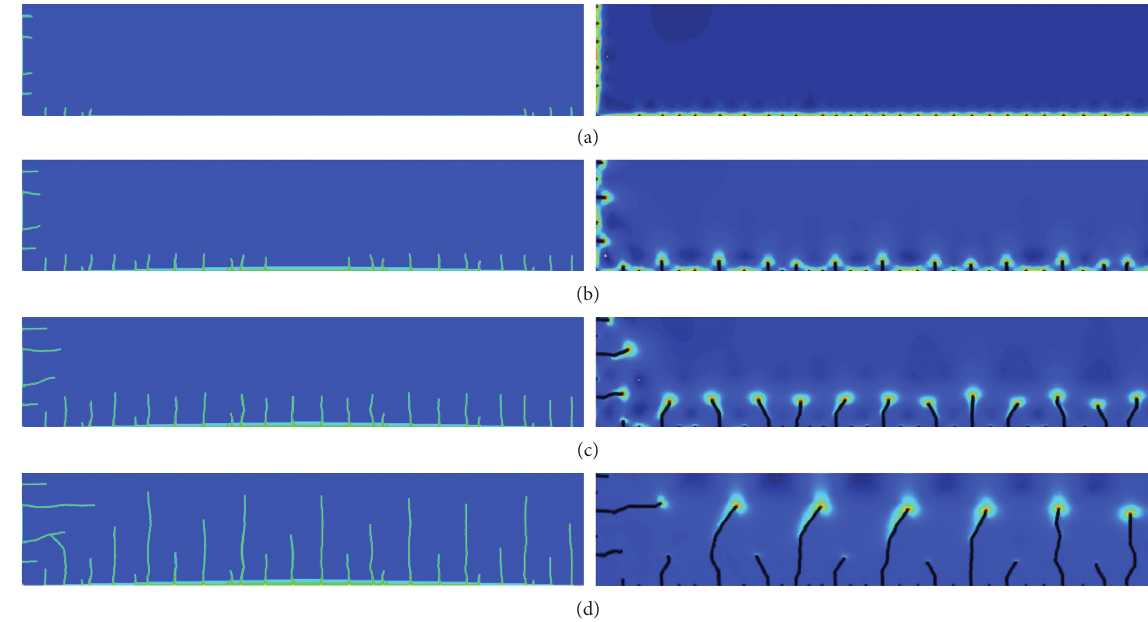
Figure 5: Thermally induced crack initiation and propagation (left side: results predicted by the modified PD model in present work; right side: numerical results in [49] ( T 0 � 500 ° C)): (a) t � 0.002s and t � 0.0031s; (b) t � 0.006s and t � 0.0075s; (c) t � 0.05s and t � 0.0501s; (d) t � 0.9s and t � 1.1552s.